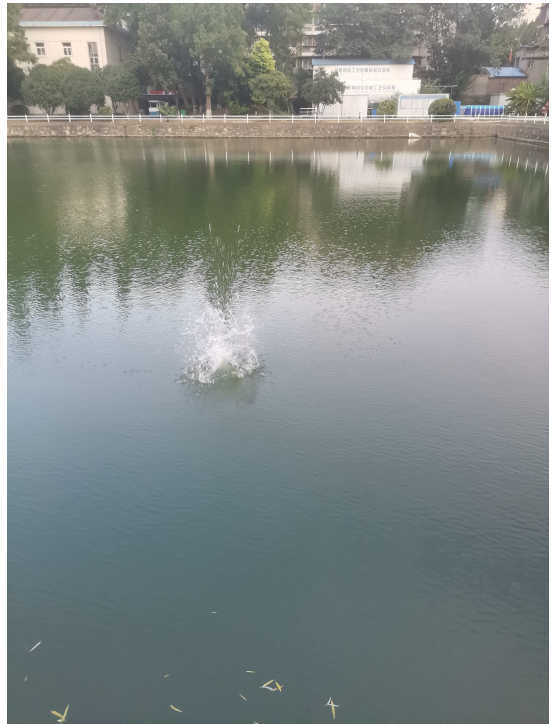
Figure 13. Experimental site